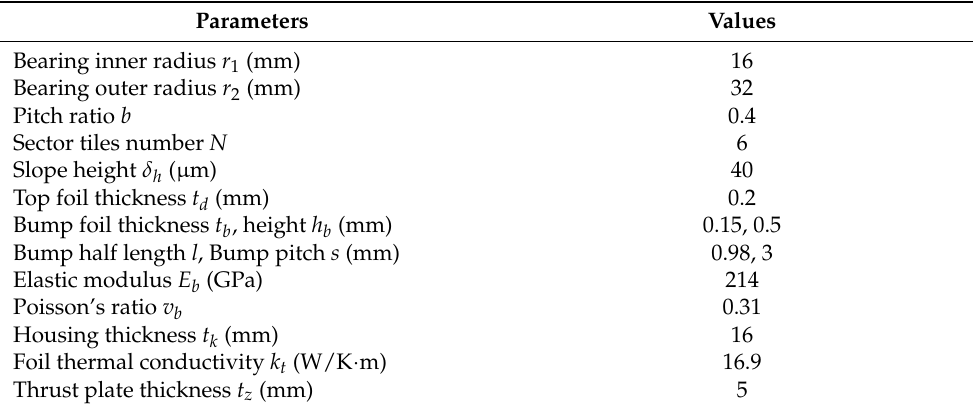
Table 1. This is a table. Tables should be placed in the main text near to the first time they are cited.